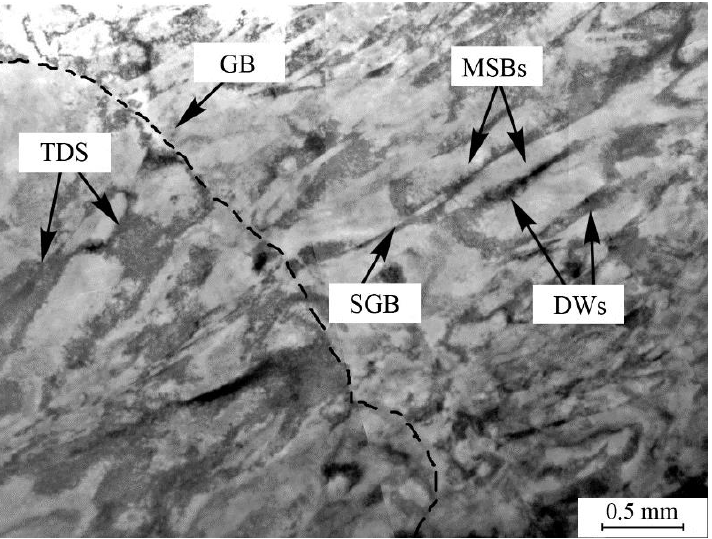
Figure 9. Characteristic microstructural elements of Ti 49.8 Ni 50.2 after abc pressing to e = 5.4: GB — grain boundary, SGB — subgrain boundary, DWs — dislocation walls, TDS — tangled dislocation structure, MSBs — microshear bands; (enlarged fragment of TEM image in Figure 7e).